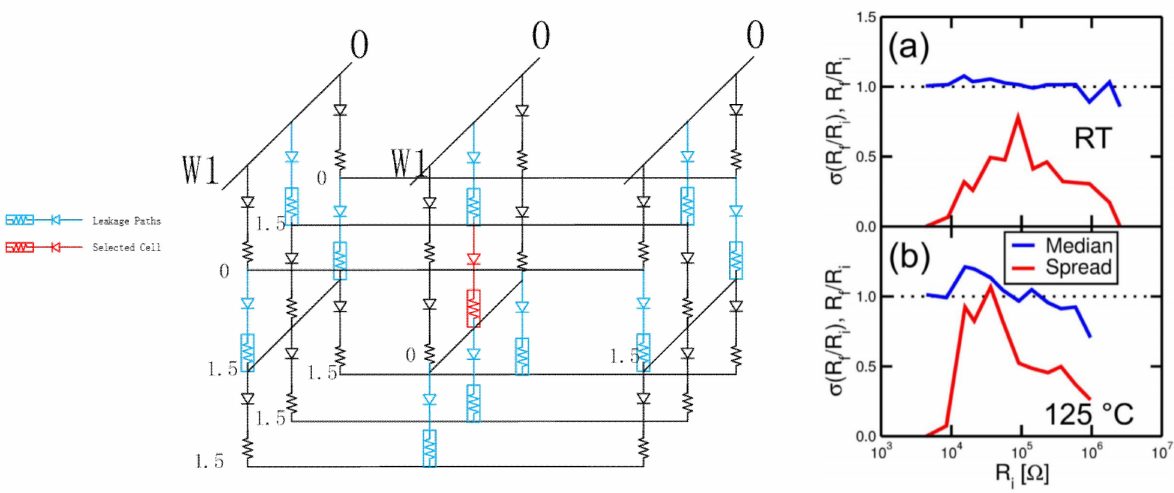
Figure 2. ( a ) Sneak current issues of cross-point RRAM [49]. ( b ) The average value and standard deviation of Rf (final resistance measured at RT)/Ri (initial resistance measured at RT) across various Ri